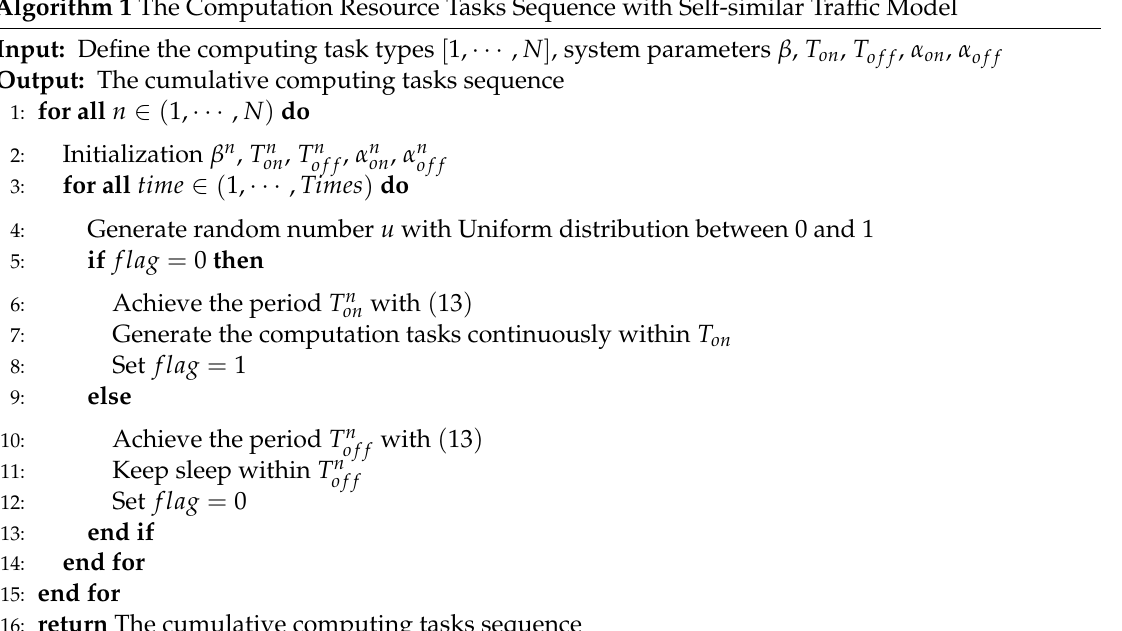
Algorithm 1 The Computation Resource Tasks Sequence with Self-similar Traffic